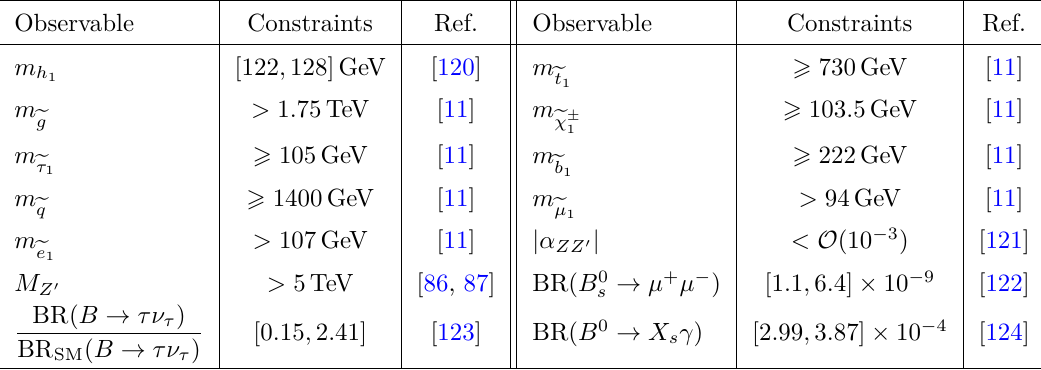
Table 4 . Current experimental and theoretical bounds used to determine consistent solutions in our